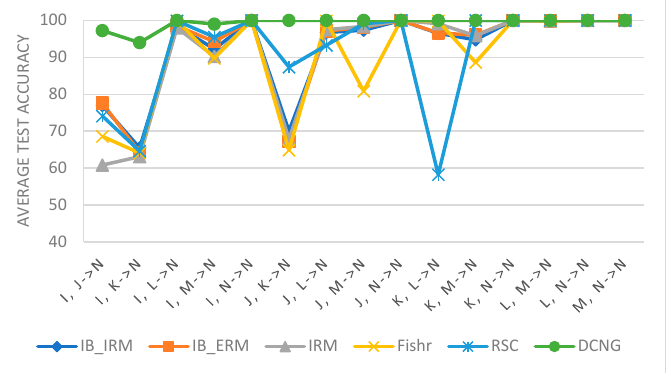
Figure 6. Performance comparison of different generalization methods on MFPT data sets.